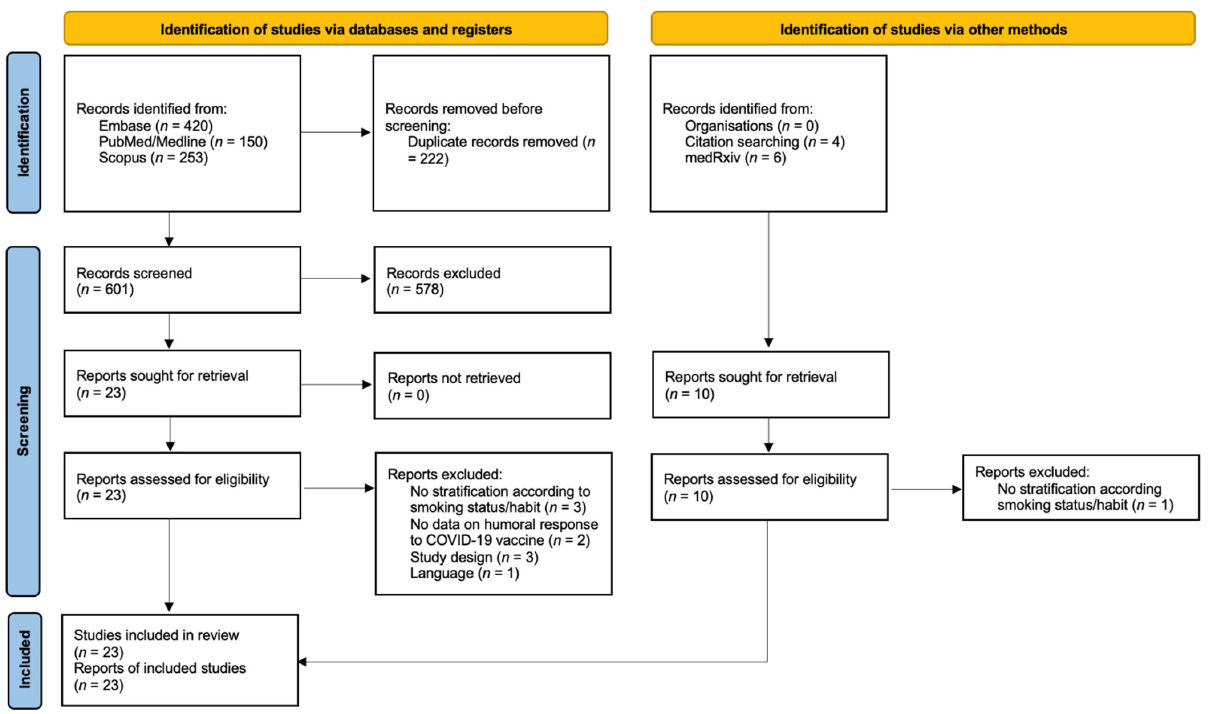
SARS-CoV-2 spike (S) protein receptor-binding domain (RBD), with specific positivity cutoff.